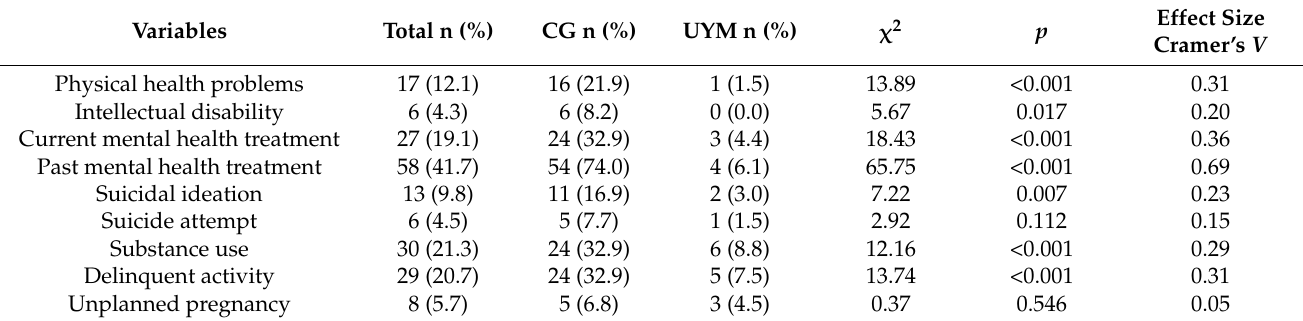
Table 2. Health and Risk Behavior. Differences between